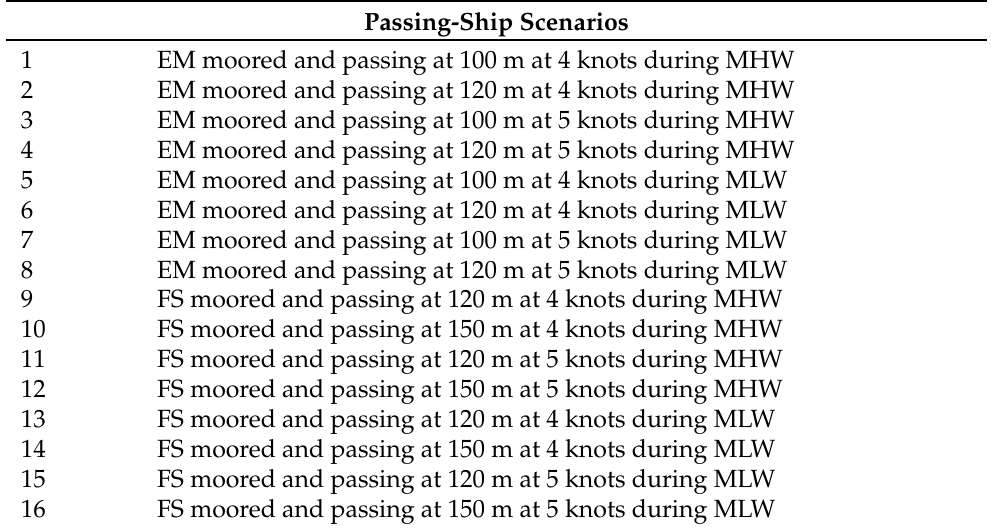
Table 5. Passing-ship scenarios simulated. EM refers to Emma Maersk and FS to the future